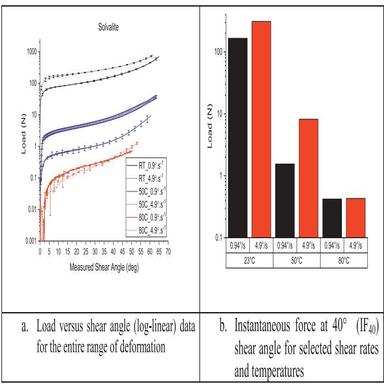
BE test results of CEP-TW1 at different temperatures and shear rates.